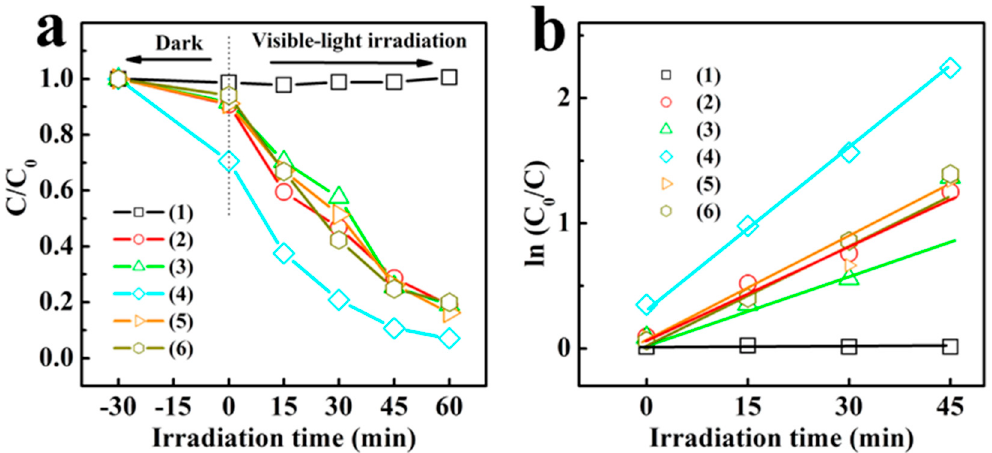
Figure 4. ( a ) Photocatalytic degradation curves and ( b ) the corresponding kinetic linear simulation curves of methyl orange (MO) over the different samples: (1) PAN nanofiber; (2) BiOBr/PAN CMs; (3) AgBr/BiOBr/PAN CMs-1; (4) AgBr/BiOBr/PAN CMs-2; (5) AgBr/BiOBr/PAN CMs-3; (6) AgBr/BiOBr/PAN CMs-4. C 0 : the initial concentration of MO; C: the residual concentration of MO. Table 1. The photocatalytic degradation parameters over the different nanofiber photocatalysts. Photocatalyst Light Photocatalytic Results Year Ref.